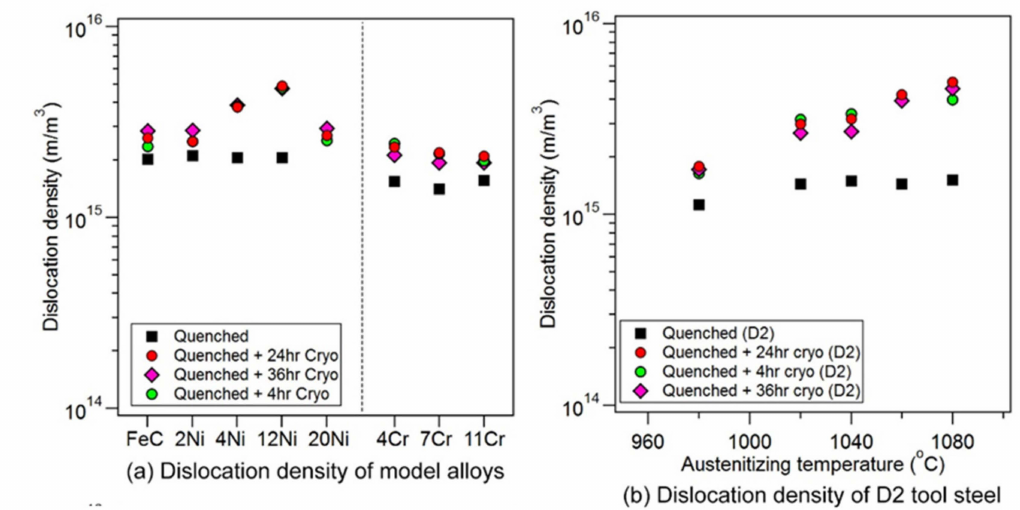
Figure 4. Dislocation density of martensite for all alloys examined in this study, measured using XRD. Data shown for cryogenic soaking times of 4, 24, and 36 h. Fitting error approximately the same size as data